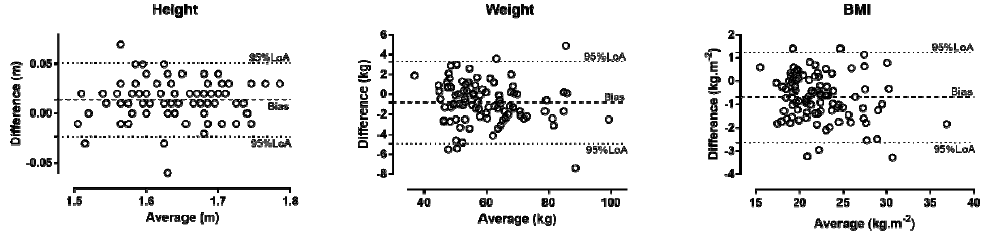
Figure 1. Bland–Altman plots showing the difference (bias) between reported and measured height, weight, and body mass index. BMI = body mass index; LoA = limit of agreement; Difference = reported − measured; Average = (reported + measured)/2.